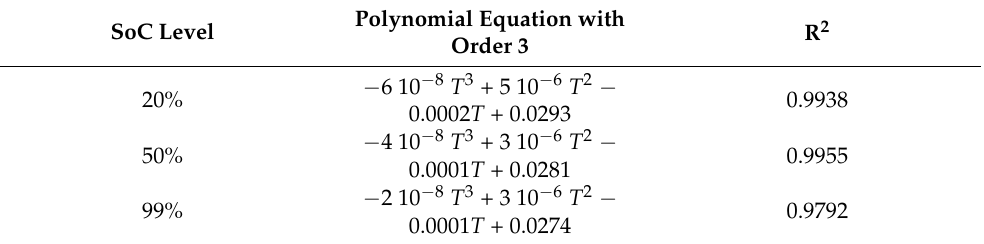
Table 2. Curve Fitting Polynomial.